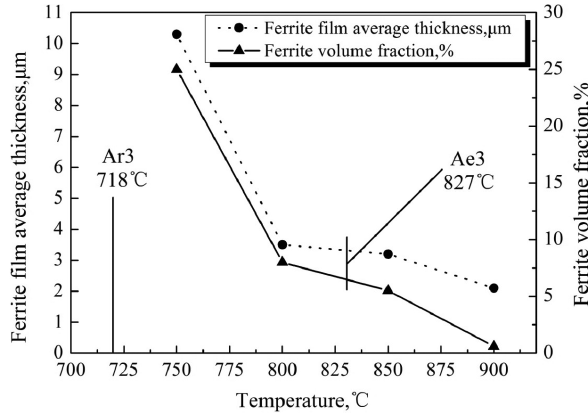
Fig. 7: Ferrite film average thickness and ferrite volume fraction as a function of temperature in Ti-bearing steel.